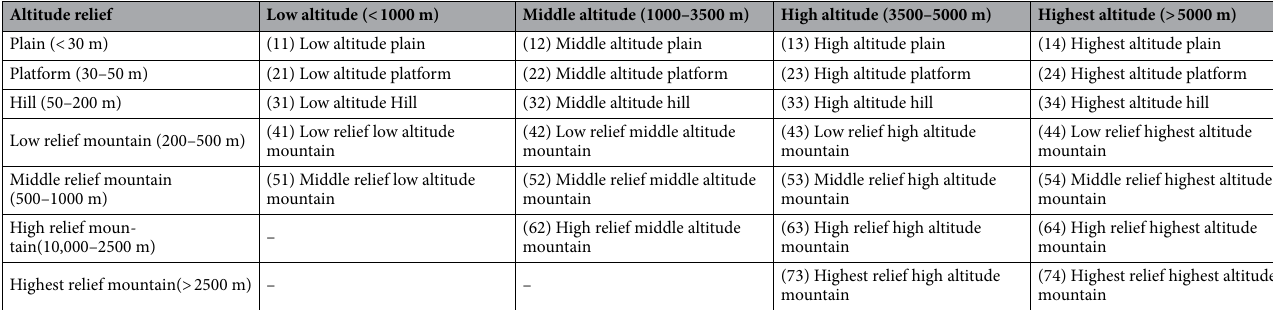
Table 1. Classification of the basic terrestrial geomorphologic types of study area. Geomorphologic type codes are in parentheses.